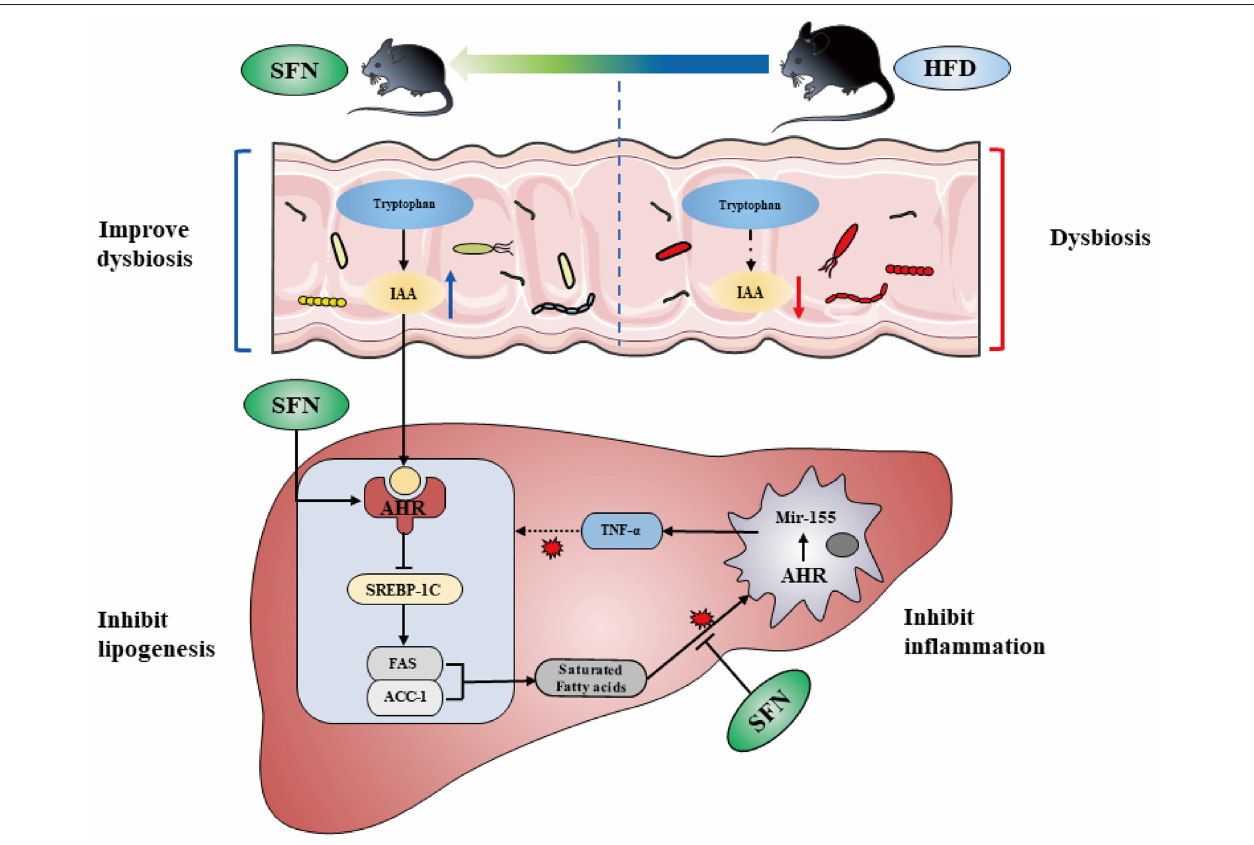
FIGURE 7 | SFN altered the gut microbiota of mice and microbiome-derived metabolite IAA. Additionally, SFN regulated liver lipid metabolism by activating AHR and inhibited chronic low-grade